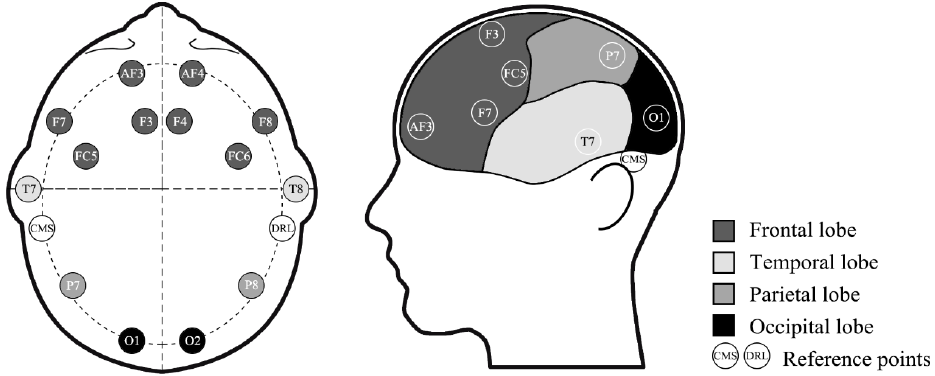
Figure 3. Areas of the four brain lobes and the positions of the 14 channels.